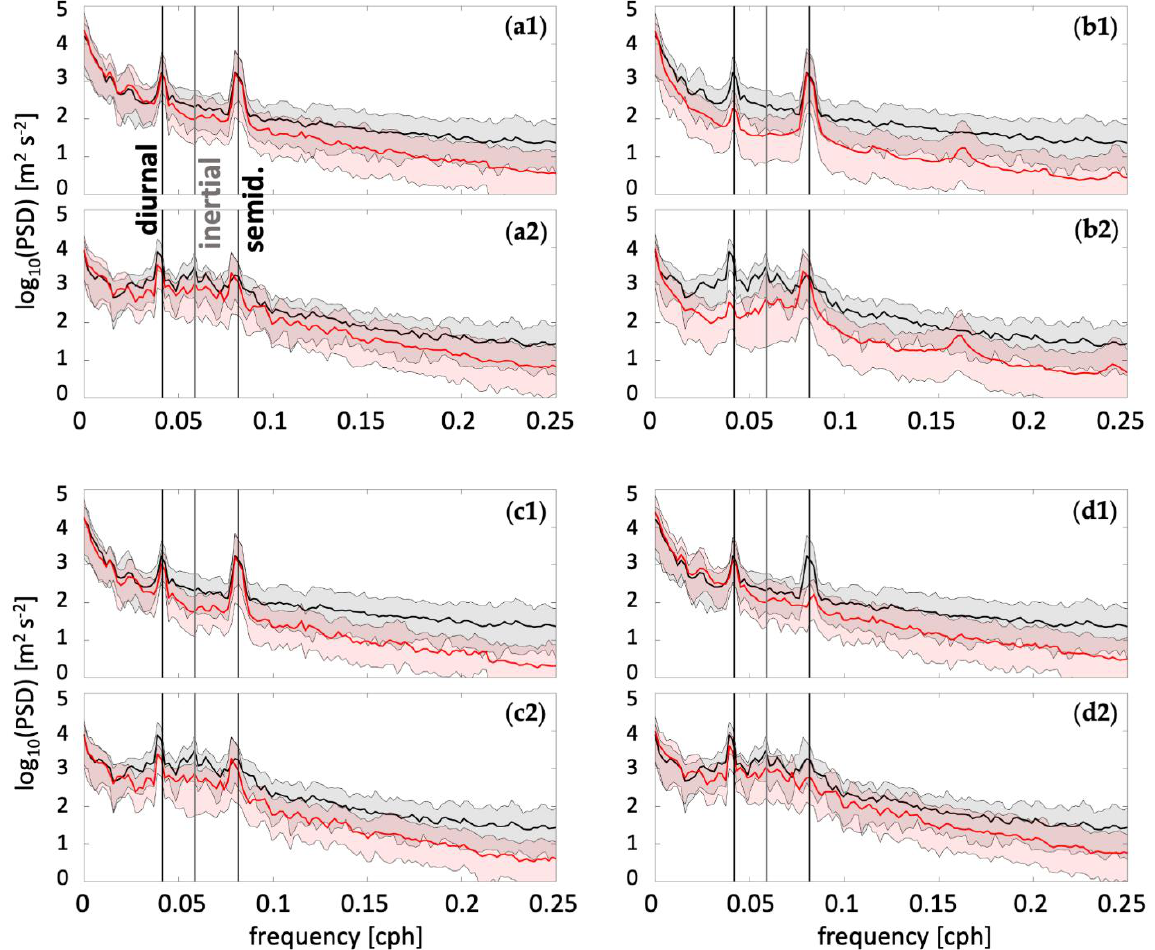
Figure 9. Spatially-averaged power spectral densities (PSD) of HFR observations and model simulations, with corresponding 5th-95th percentiles, for the period April-May 2012. Black (red) curves correspond to HFR data (model simulations). The panels show the comparison between the HFR data and the numerical simulation ( a1 , a2 ) in its full configuration (RR) and without ( b1 , b2 ) wind forcing (NW), ( c1 , c2 ) river input (NR) and ( d1 , d2 ) tidal forcing (NT). Units for PSD and frequency are log 10 (m 2 s − 2 ) and cph (cycles per hour), respectively. PSD plots are split between cyclonic (1) and anticyclonic (2) portions, respectively.